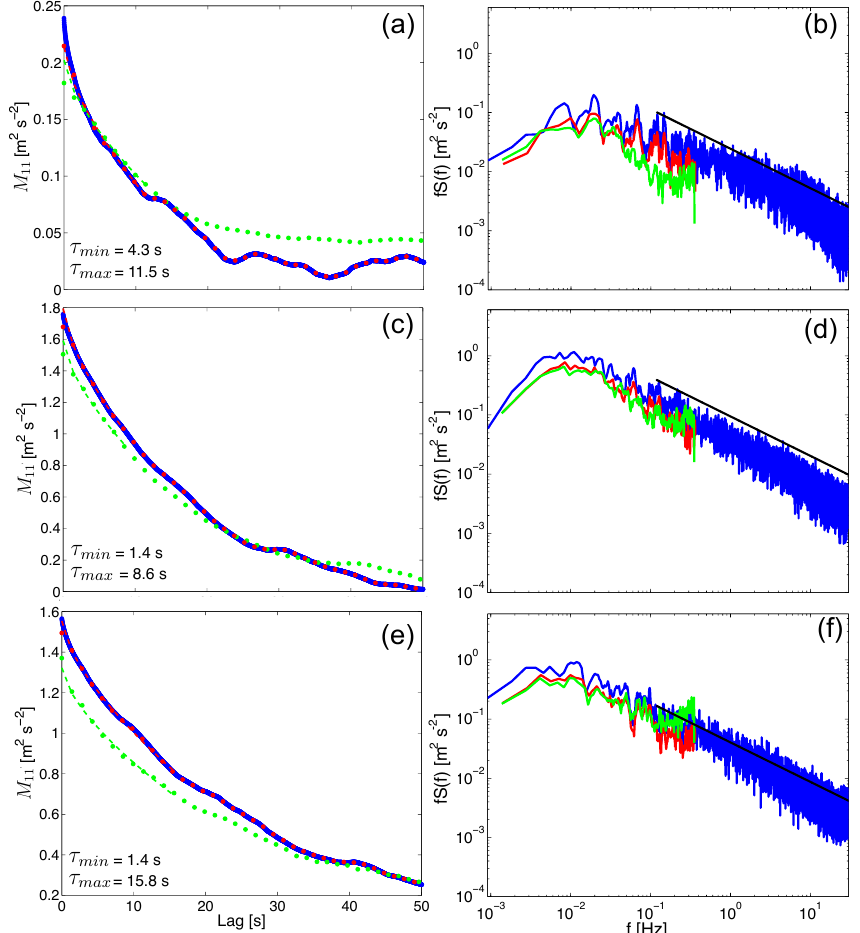
Figure 8. Sample M 11 (left column) and the corresponding spectra (right column) averaged over different 30min time periods for mea- surements at 300m. Measurements shown are those calculated from the raw sonic observations (blue), sonic data averaged to match the lidar averaging time (red), and OU DL observations (green). Dashed lines overlaid on M 11 are the fittings of the structure function fit to the corresponding measurement. The solid black line in the spectra denotes the theoretical − 2/3 slope in the inertial subrange. The fitting for the filtered sonic data uses the same lags as for the DL. M 11 and the spectra are computed over 05:30–06:00UTC (a, b) , 17:30–18:00UTC (c, d) , and 23:00–23:30UTC (e, f) on 27 March. Observations in (a, b) are during stable conditions ( Ri = 0 . 64), while data shown in (c–f) are during near-neutral conditions ( | Ri | < 0.05). Values of τ max and τ min for each time period are shown in the lower left of (a, c, e) . Spectra are smoothed for clarity using a 5-point moving